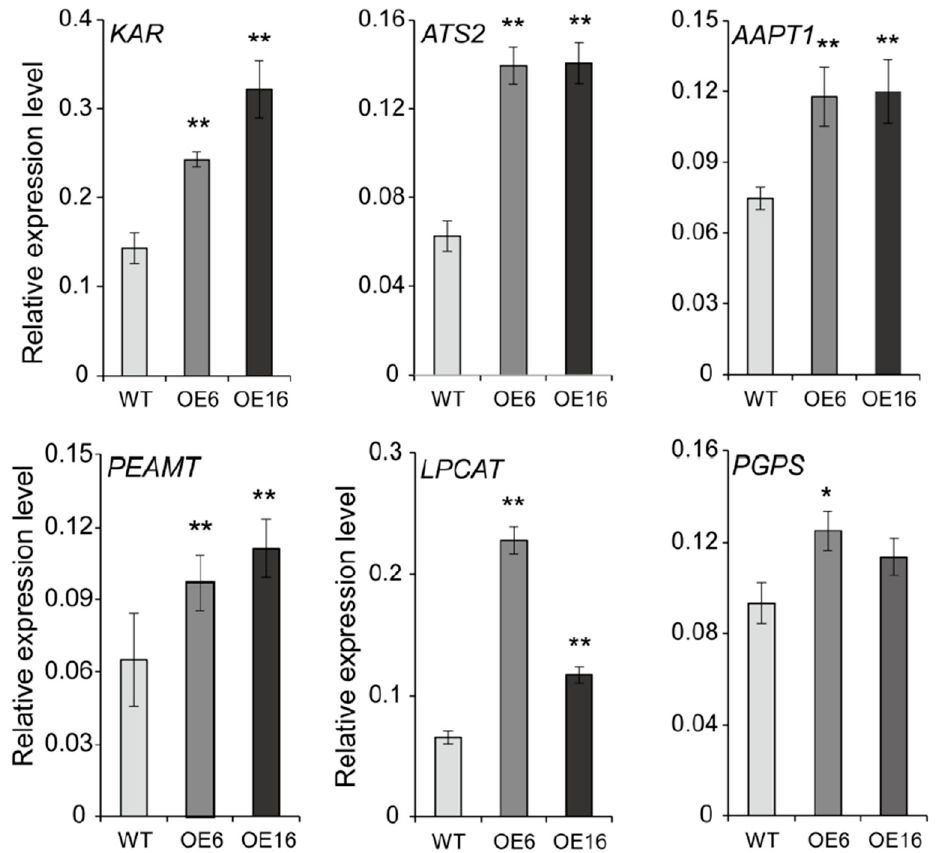
Figure 6. Overexpression of BnATS1 enhanced expression of genes related to the lipid anabolic process. Total RNA was extracted from leaves of 40-day-old plants under field growth conditions. The relative expression levels of genes were analyzed by real-time PCR normalized to the β -Actin expression level. Values are means ± SD ( n = 3 separate samples). * and ** denote significance at p < 0.05 and p < 0.01, respectively, compared with WT plants based on Student’s t test.